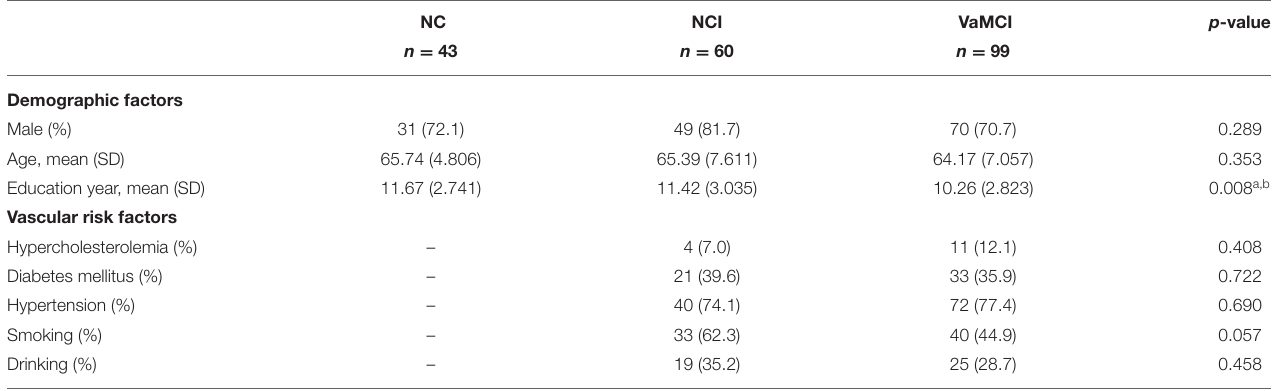
TABLE 1 | Demographic and vascular risk factors description.